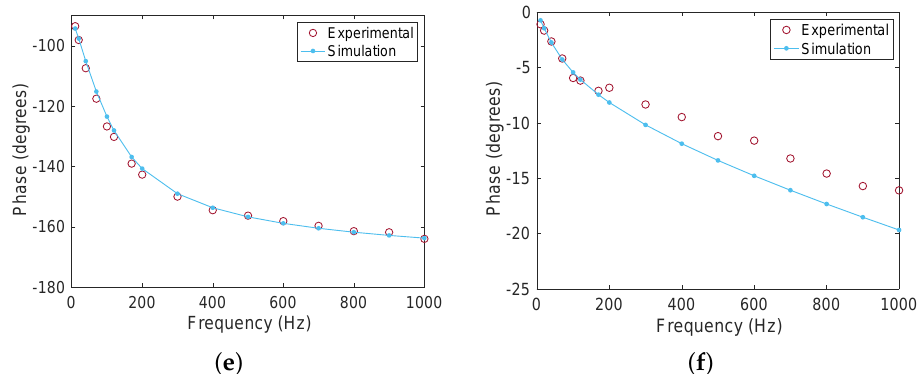
Figure 6. Experimental and simulation results for the secondary magnetic field for solid aluminium, ( a , c , e ), and steel cylinders, ( b , d , f ), when varying the frequency between 10 Hz to 1 kHz. ( a , b ): In- phase I and out-of-phase Q components; ( c , d ): ratio of the amplitude of the secondary magnetic field to the primary magnetic field at the magnetometer position ( e , f ): phase (in degrees) of the secondary magnetic field with respect to the primary magnetic